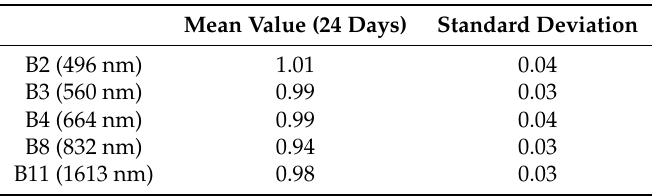
Table 9. Calibration coefficient (ratio of Sentinel-2A Level 1C products to La Crau top-of-atmosphere (TOA)